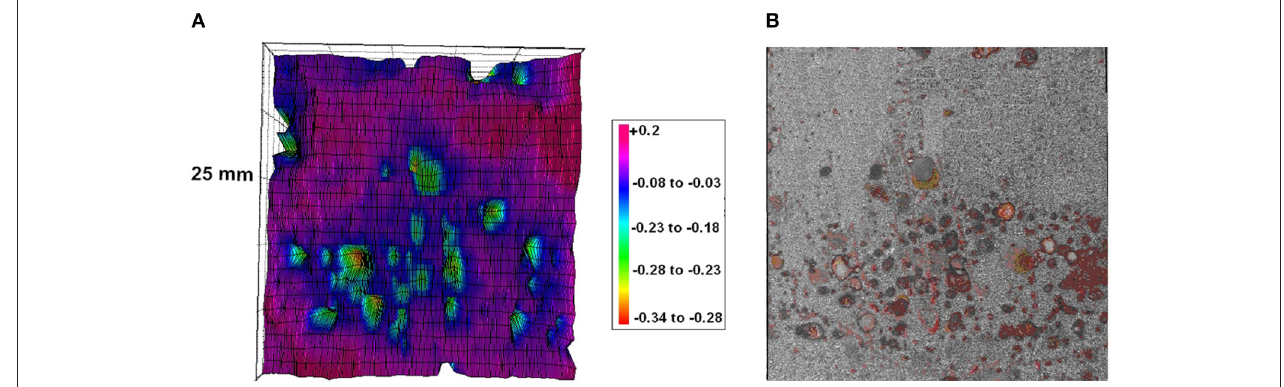
FIGURE 6 | (A) SKP map (V vs. SHE) and (B) the photograph of the steel surface after coating removing. The substrate was contaminated by NaCl (20 µ g/cm 2 ). Epoxy-vinyl coating thickness 100 µ m. The measurement was carried out in air at 95% RH. Reprinted with permission from NACE International (Nazarov et al.,